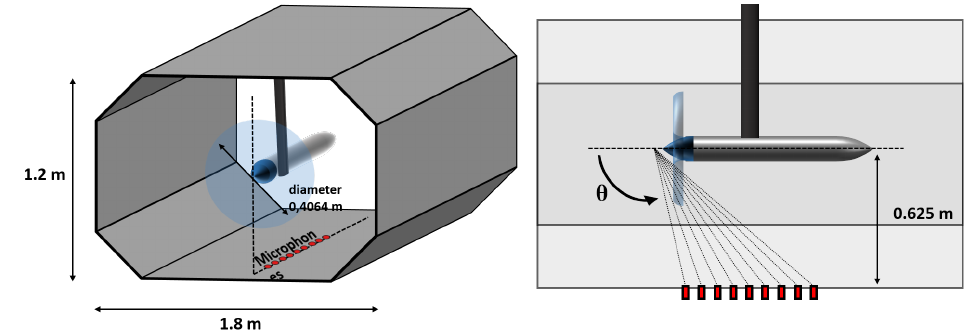
Figure 3. Schematic representation of the experimental setup located within the wind